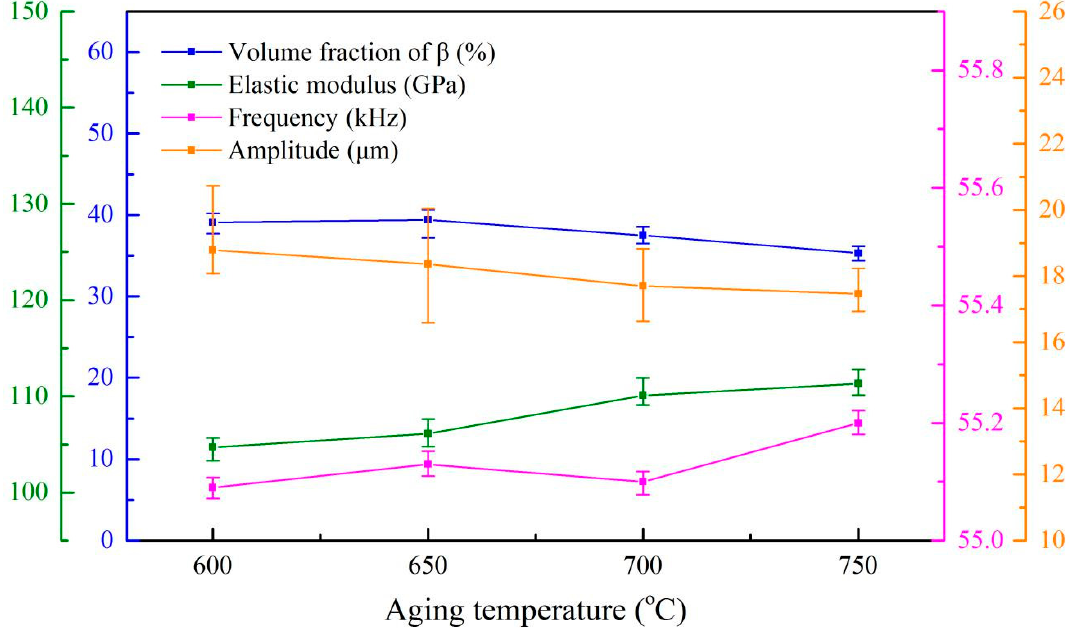
Figure 11. The relationship between β phase content, the elastic modulus, the ultrasonic resonant frequency and the amplitude of Ti6Al4V alloy under different solution temperature.